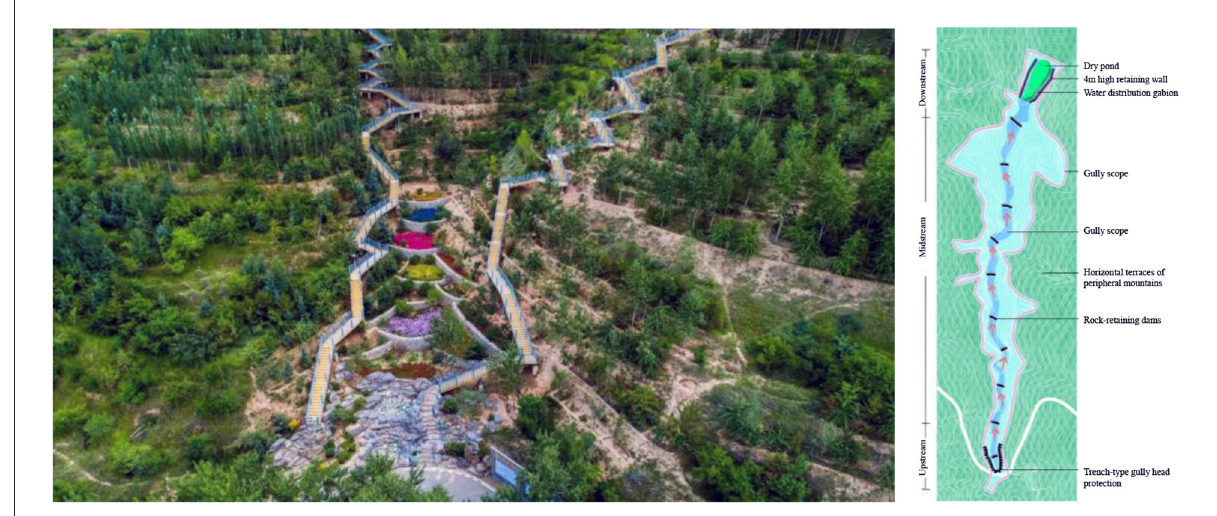
FIGURE9 Mountain gully management model and construction effect in